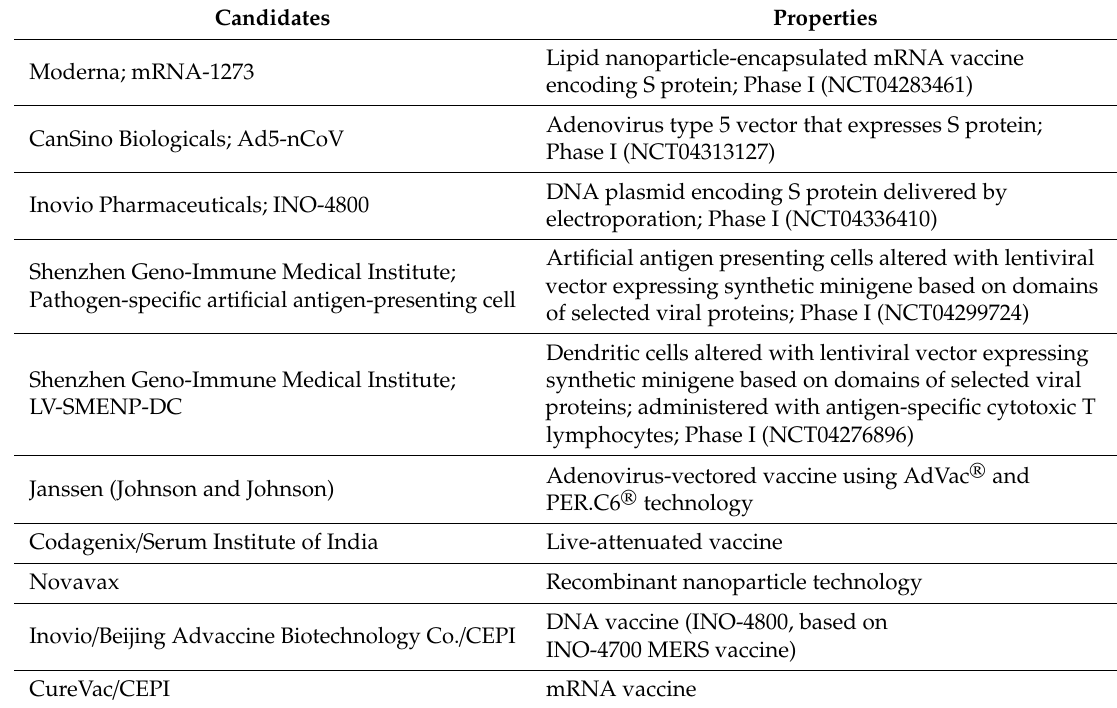
Table 2. Some important vaccine candidates for